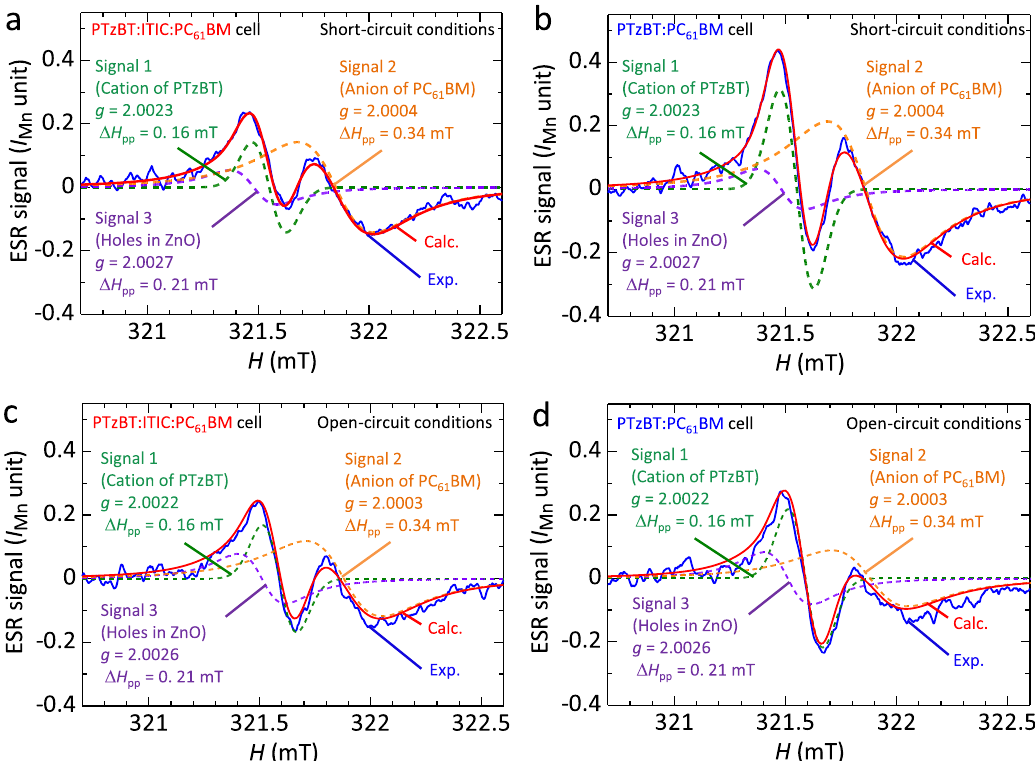
Fig. 6 Fitting analyses of the operando ESR signals of the PTzBT cells after 20 h solar irradiation. a – d Fitting analyses of the ESR signals of the PTzBT cells ( a , c ) with and ( b , d ) without ITIC under ( a , b ) short- and ( c , d ) open-circuit conditions in low magnetic fi elds at around 321.5 mT, respectively. Red lines represent the sum of green dotted line (Signal 1, cation of PTzBT), orange dotted line (Signal 2, anion of PC 61 BM), and purple dotted line (Signal 3, holes in ZnO ( V þ O